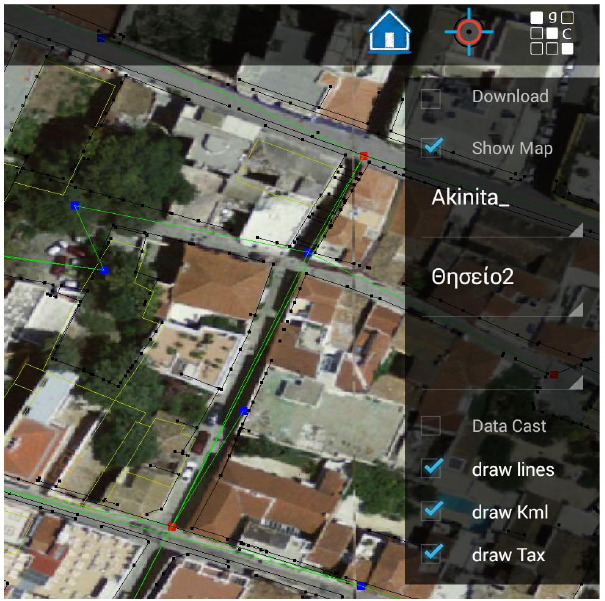
Figure 6: Portable client WMS